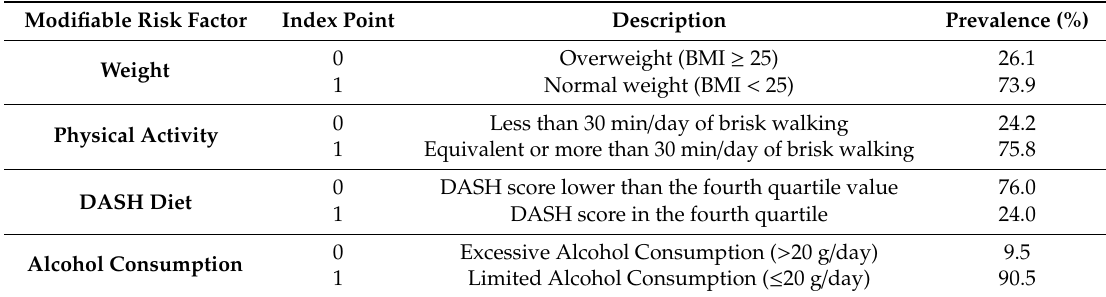
Table 1. Description and prevalence of the components of the Healthy Lifestyle Index (HLI).